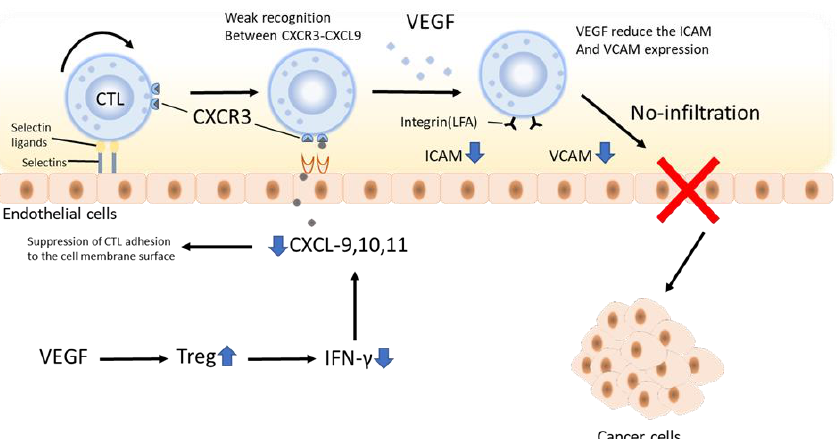
Figure 3. Mechanism of suppression of tumor infiltration of CD8-positive T cells by VEGF. In the cancer immune cycle, VEGF prevents infiltration of CD8-positive T cells flowing in the blood into the tumor. The main factors are that VEGF induces FAS ligand and causes CTL to undergo apoptosis, and that by reducing adhesion factors such as ICAM-1 and VCAM-1, CTL adheres to the vascular endothelium and migrates to tumors. known to reduce performance. Furthermore, blocking the release of chemokines such as CXCL9, 10, and 11, which are ligands of CXCR3, from intratumoral dendritic cells prevents CTL from adhering to vascular endothelium and inhibits intratumoral invasion.